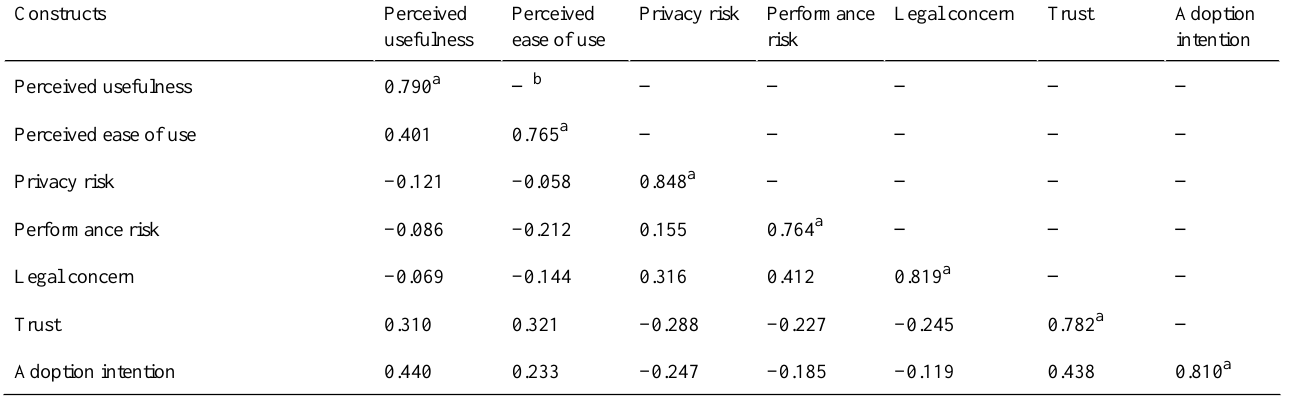
Table 3. Correlation coefficient matrix and square root of average variance extracted of latent variables.